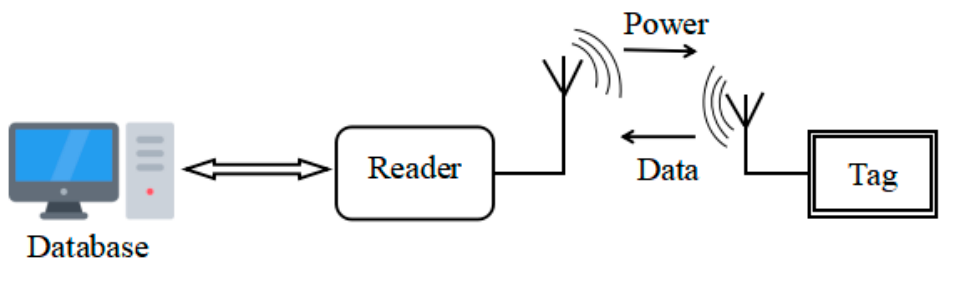
Figure 1. Working principle of the RFID system.